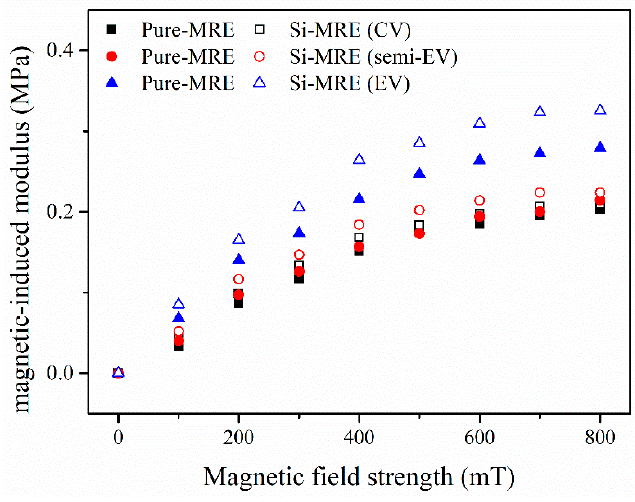
Figure 5. Magnetic-induced modulus of the MRE and Si-MRE with various vulcanization systems.